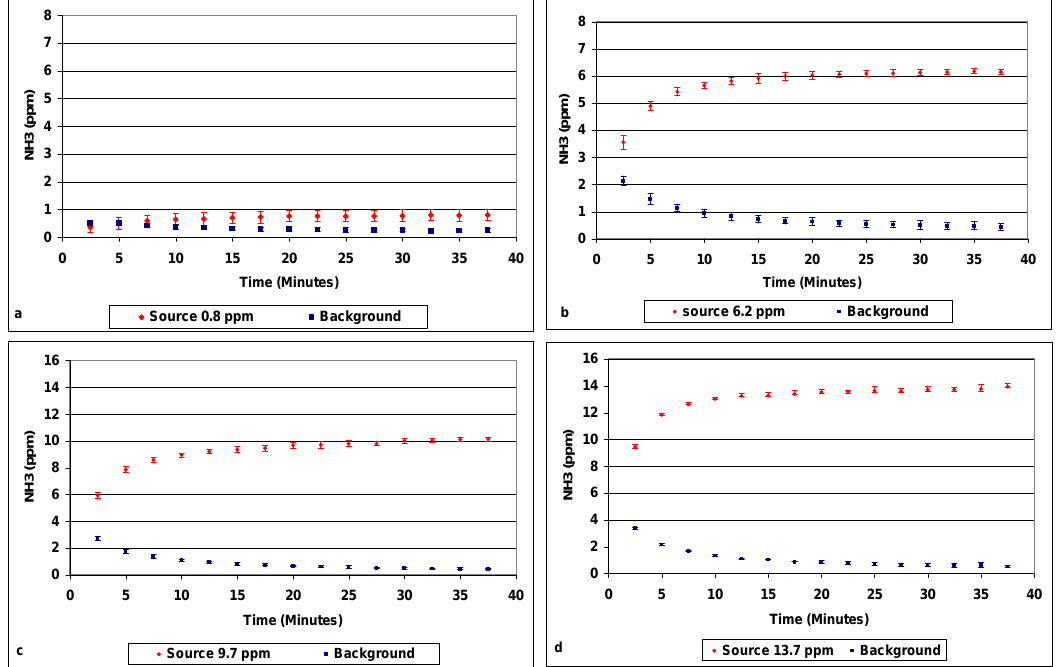
Figure 3. Time delay when switching between high and low concentration positions (a) = 0.8 ppm; (b) = 6.2 ppm; (c) = 9.7 ppm and (d) = 13.7